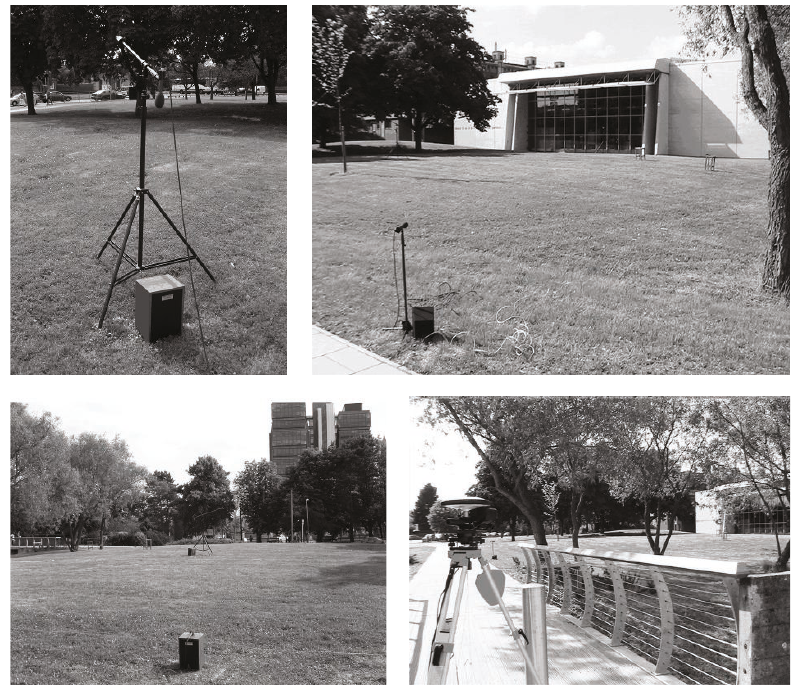
Figure 7: The experimental site and the equipment setup on the site.